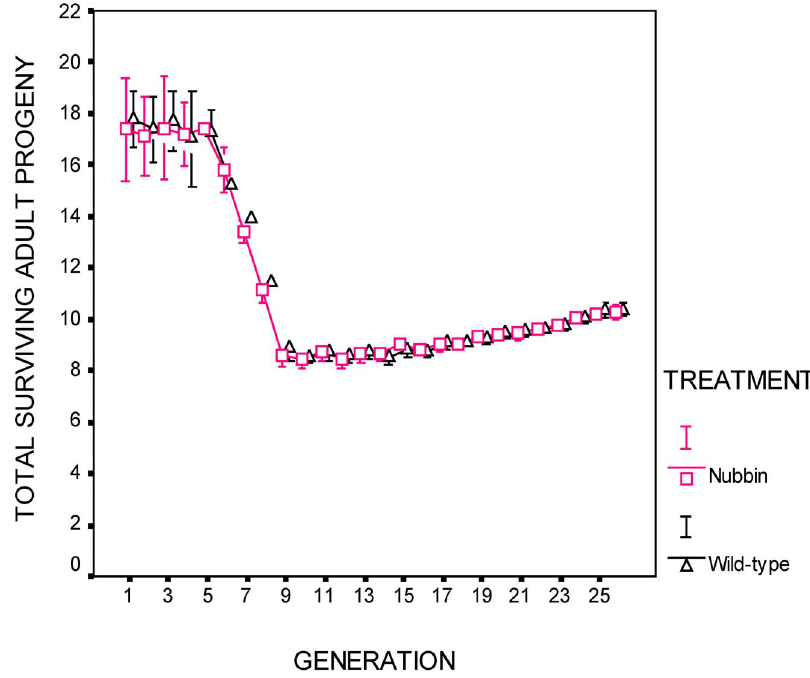
Figure 1. Total surviving adult progeny per female. Populations entered the thermal stress regime in generation 6. There was no difference between treatments (p=0.64). Error bars are 6 one standard error. See Table 1b.